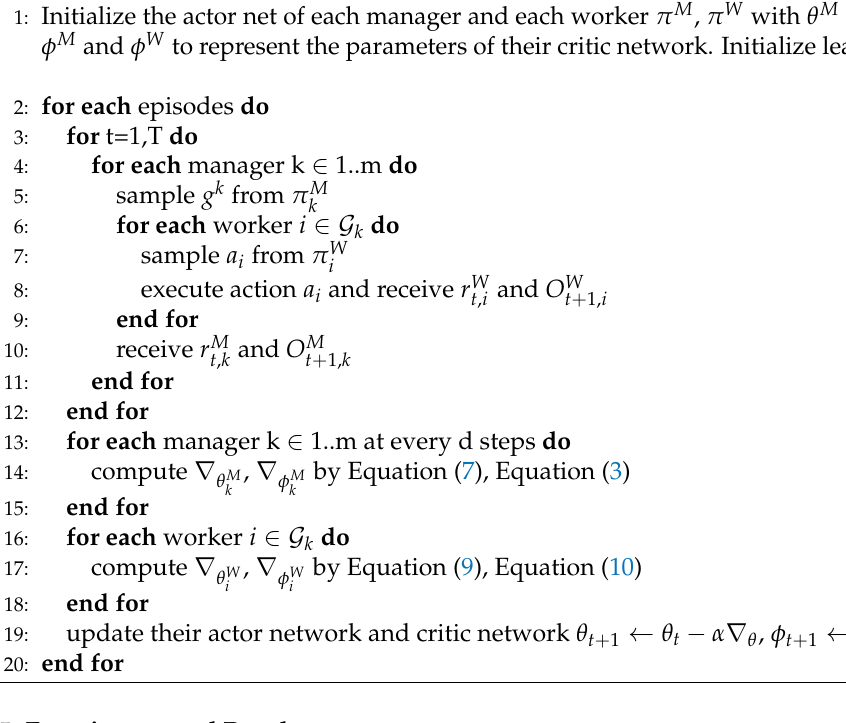
Algorithm 1 Goal-based multi-agent hierarchical